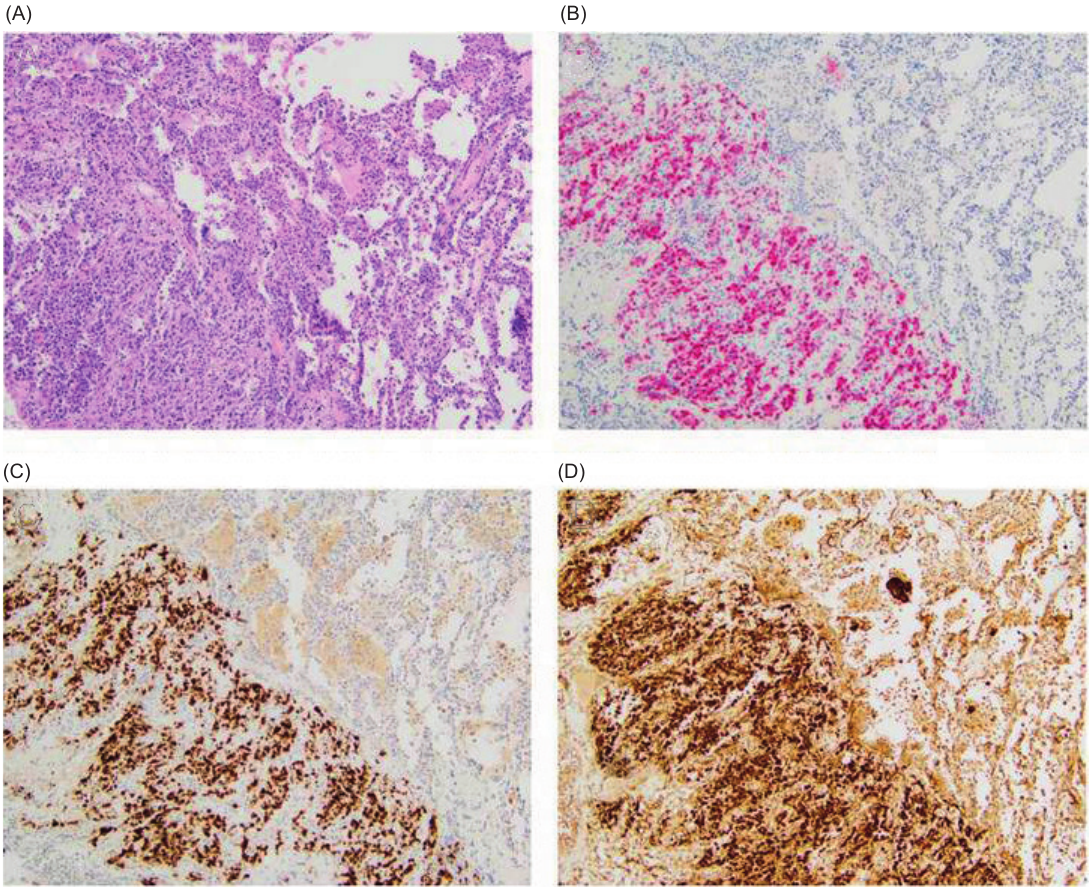
Figure 3: Lung metastasis tumor histology with immunohistochemical staining. The metastatic foci in the lung (original magnifi- cation ×100) have similar morphology compared to the primary lesion on H&E (A). By immunohistochemistry, these lesions are positive for MART1 (B), HMB45 (C), and Cathepsin K